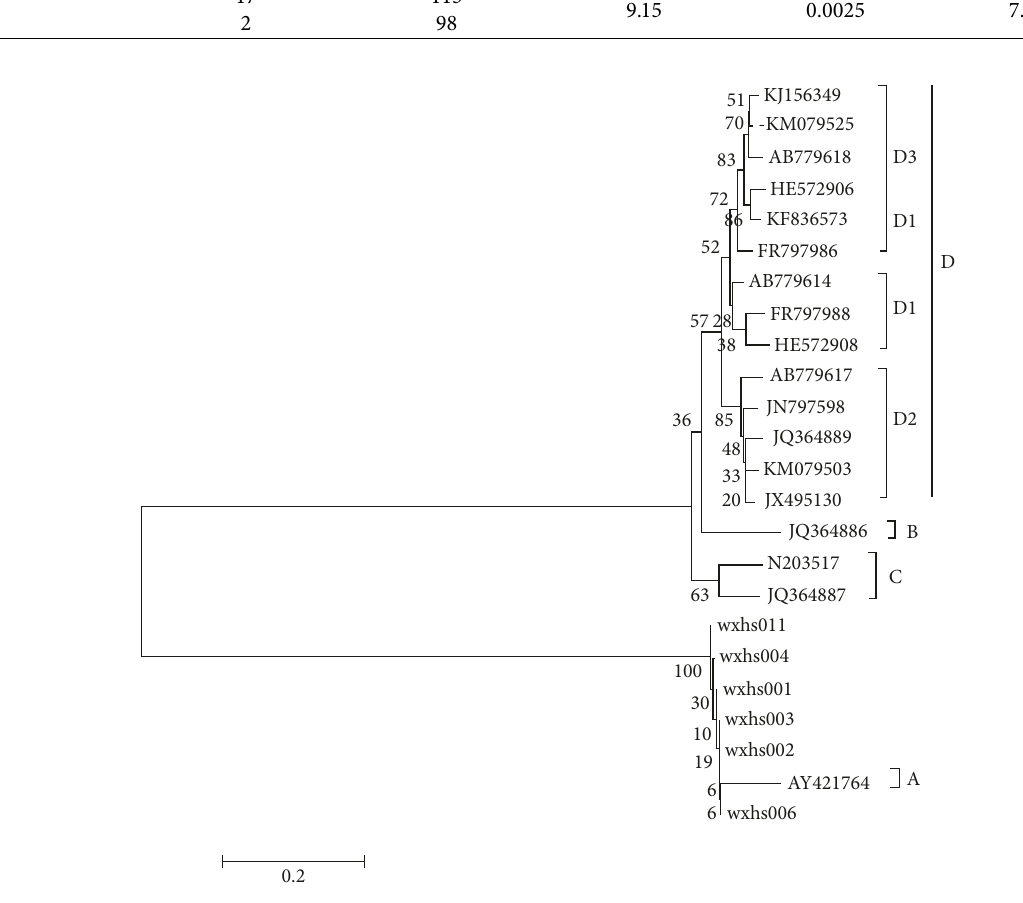
Figure 4: The phylogenetic tree of the six positive samples’ VP1